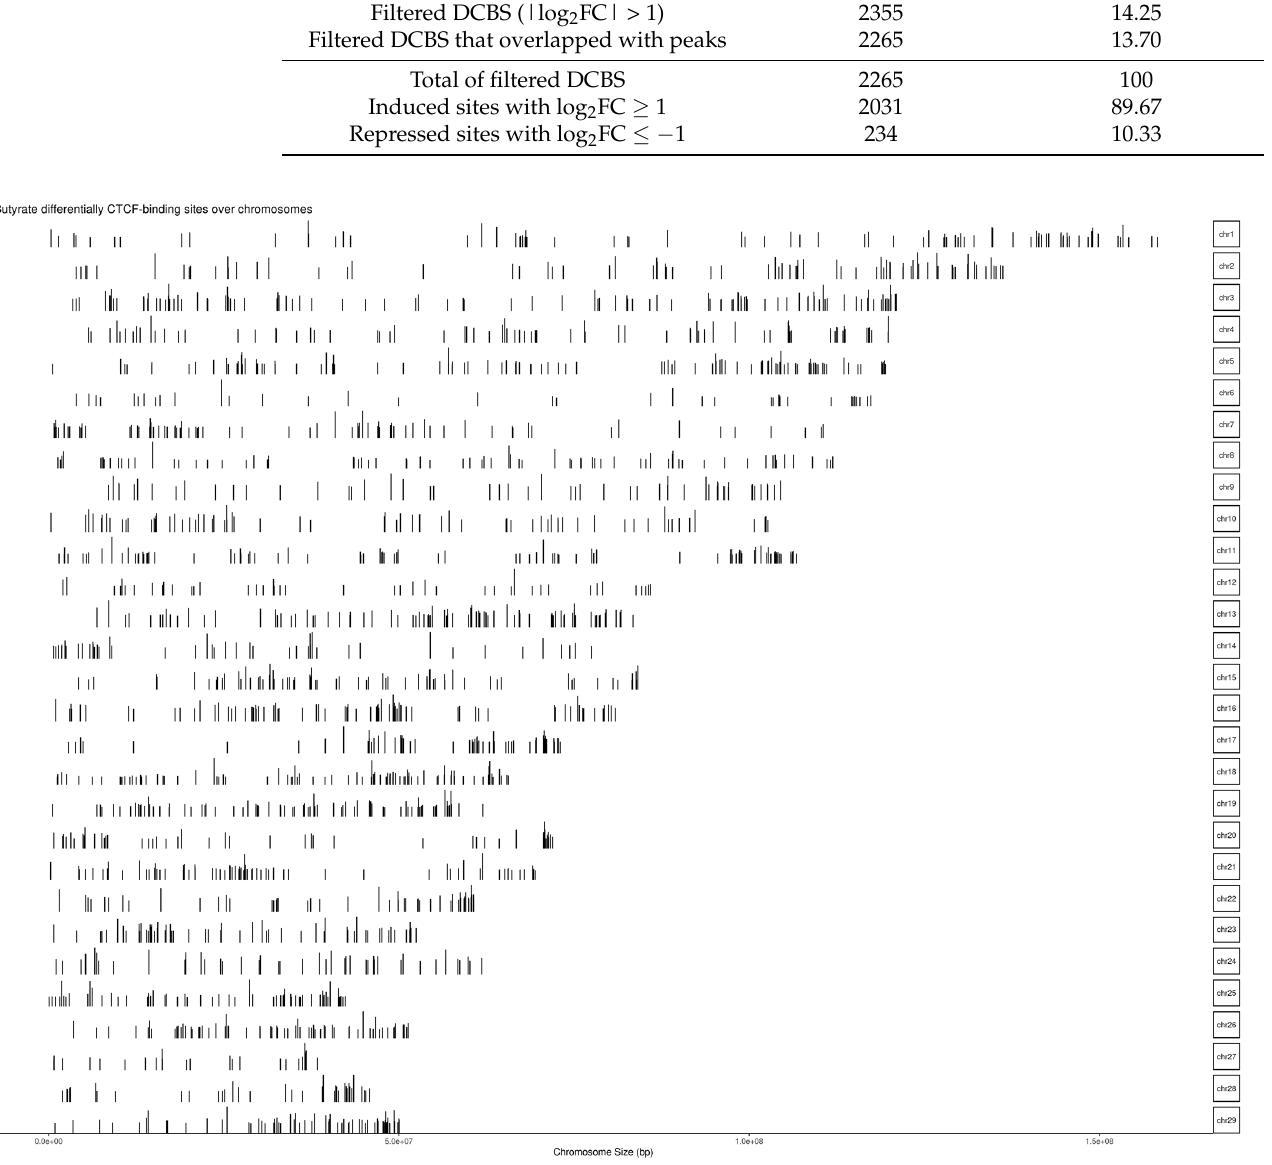
Table 3. Number of butyrate differentially CTCF-binding sites (DCBS) showing the different steps of filtration, including the number of induced and repressed regions. Filtration Steps of Butyrate DCBS Initially detected DCBS ( p -value < 0.05)